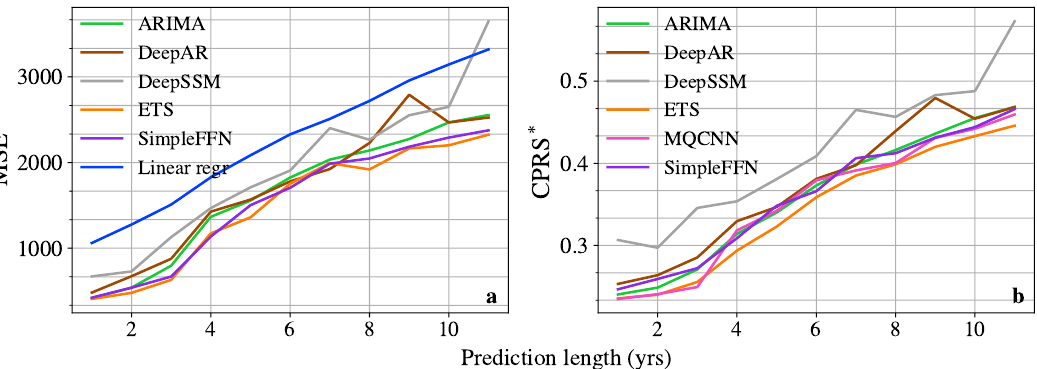
Figure 6. Relation between respectively prediction length and some accuracy measure. Models were trained and evaluated separately per prediction length. Naturally, forecast error can be expected to increase when models are set to predict longer horizons. ( a ) Forecast accuracy measured by MSE; and, ( b ) weighted quantile loss ( ∗ ), an approximation of the CRPS. The CRPS integrates quantile loss over all quantile levels and therefore generalizes MAE measures for probabilistic forecasts. OLS and SimpleLSTM are not present in this panel because only probabilistic forecasts can be evaluated by CRPS.